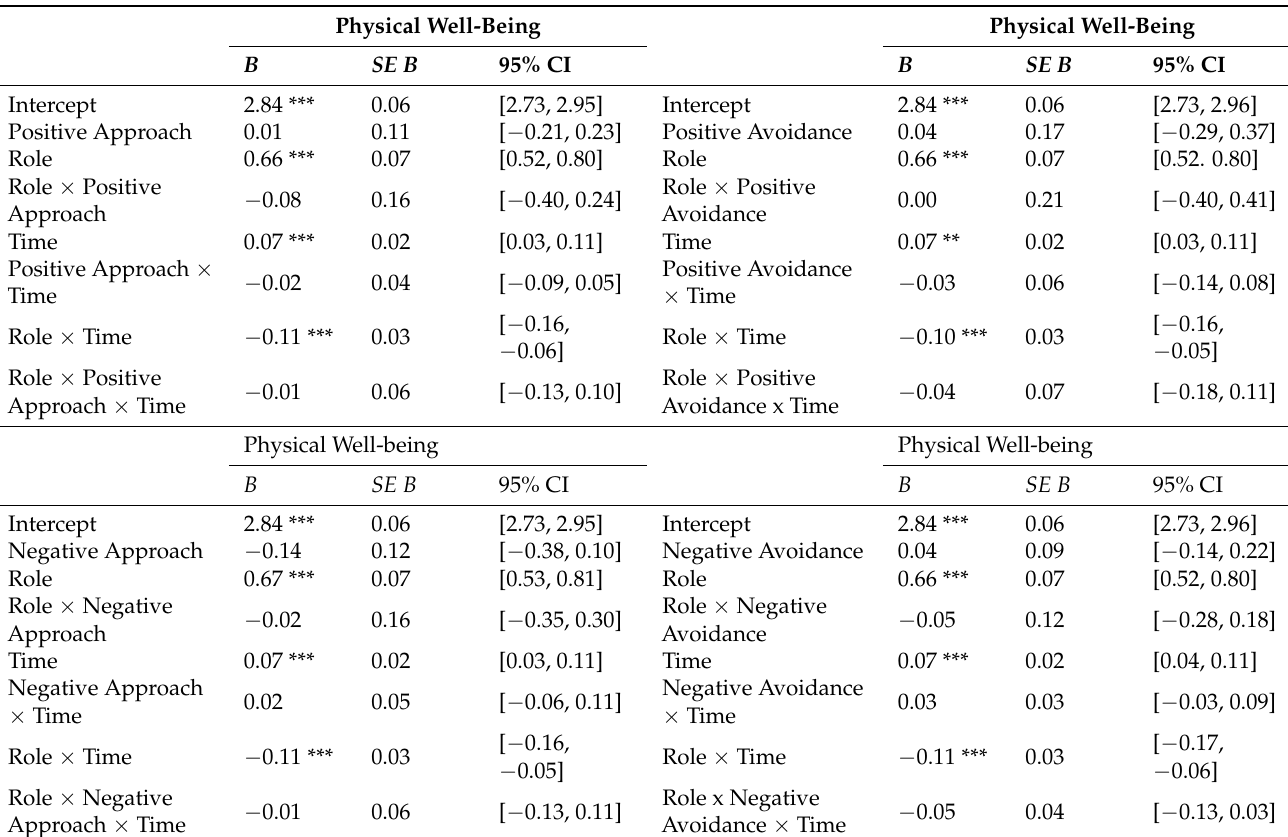
Table 7. Three-level mixed effect models of physical well-being, time, and communication behavior for patients and